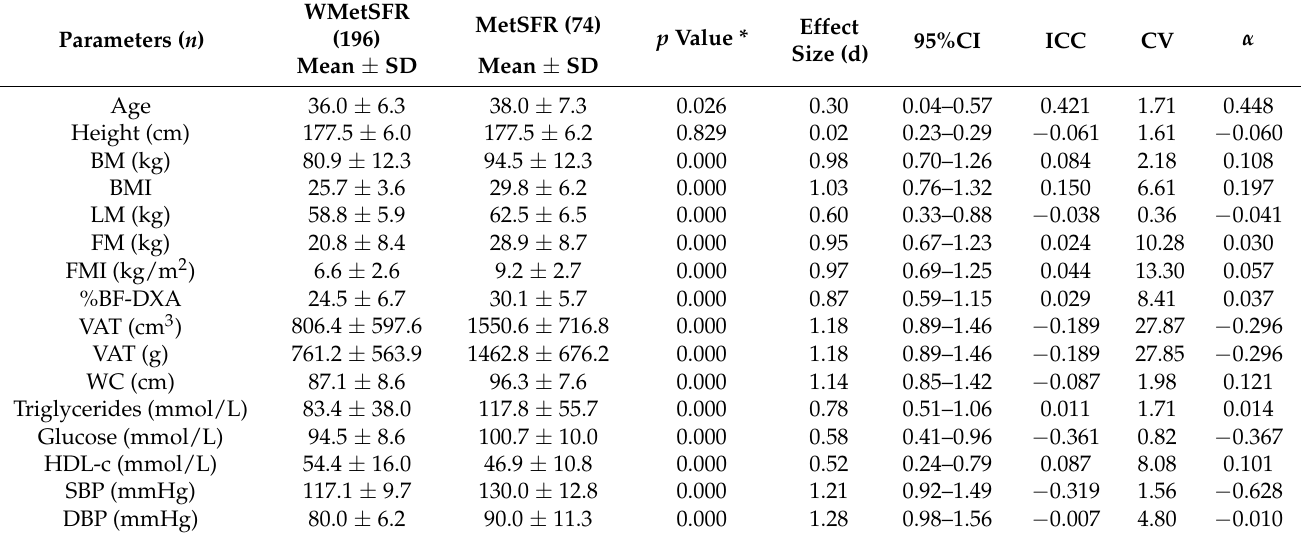
Table 1. Descriptive data of the military evaluated and comparison between groups ( n = 270).